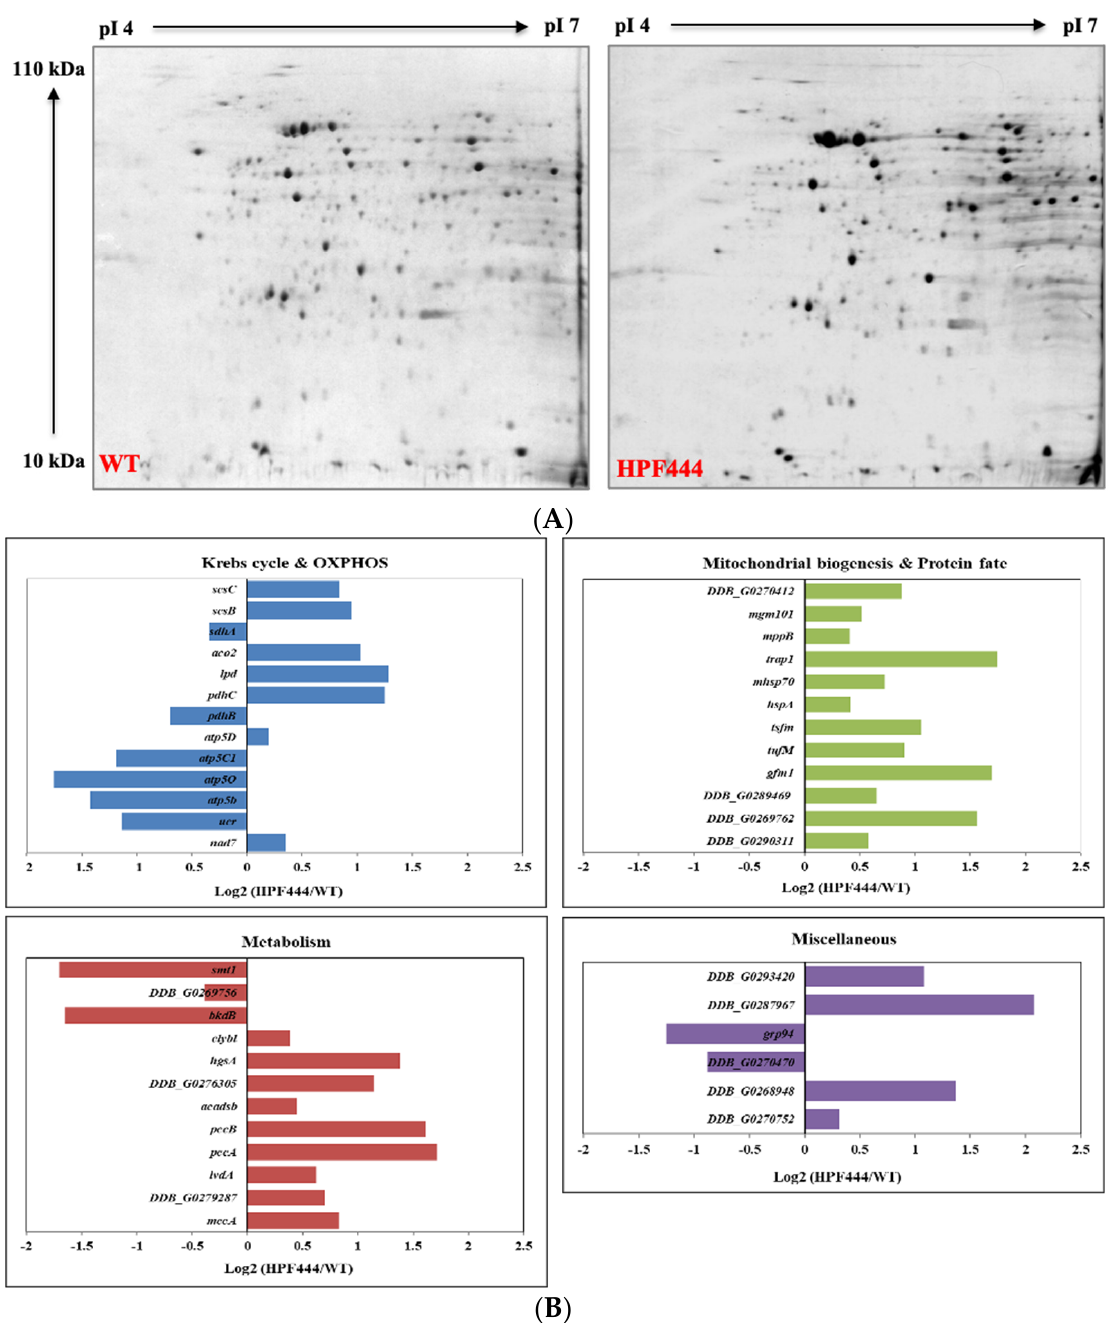
Figure 4. ( A ) Representative Coomassie brilliant blue (CBB)-stained 2-D PAGE gels of total mitochondrial proteins isolated from exponentially growing vegetative cells of D. discoideum WT and HPF444 strains. A total of 400 µ g of purified mitochondrial proteins was separated by 2-D PAGE and stained by colloidal CBB. Three independent biological replicates of each strain were analysed using Delta 2-D Software 4.2 (DECODON, Greifswald, Germany); ( B ) Relative levels of mitochondrial proteins identified by 2-D PAGE analysis in D. discoideum HPF444 strain compared to WT cells. The relative abundance of proteins is expressed as Log2 ratios. In italics, gene name of a differing protein is presented. Full names of proteins and detailed statistical analysis are given in Table S4.